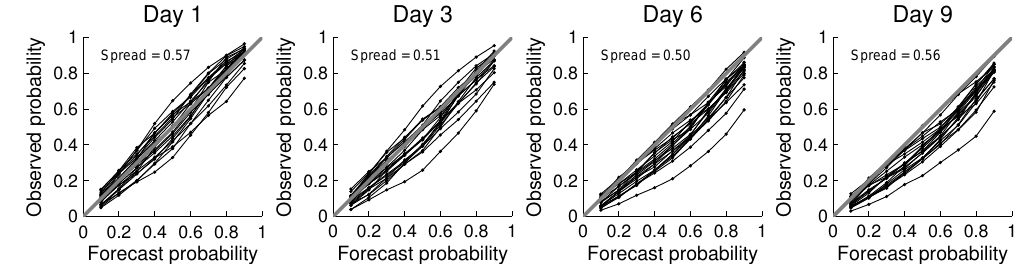
Figure 12. Reliability of the EnKF multimodel ensemble with MEPS forcing and lower input–output perturbations (system H (cid:48)